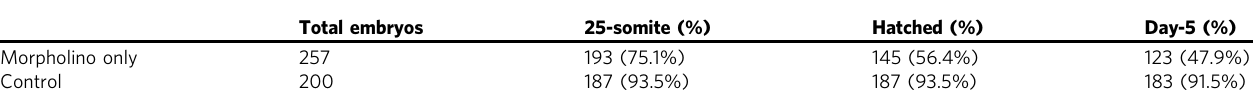
Table 1 Survival rate of the recipients of morpholino injection.